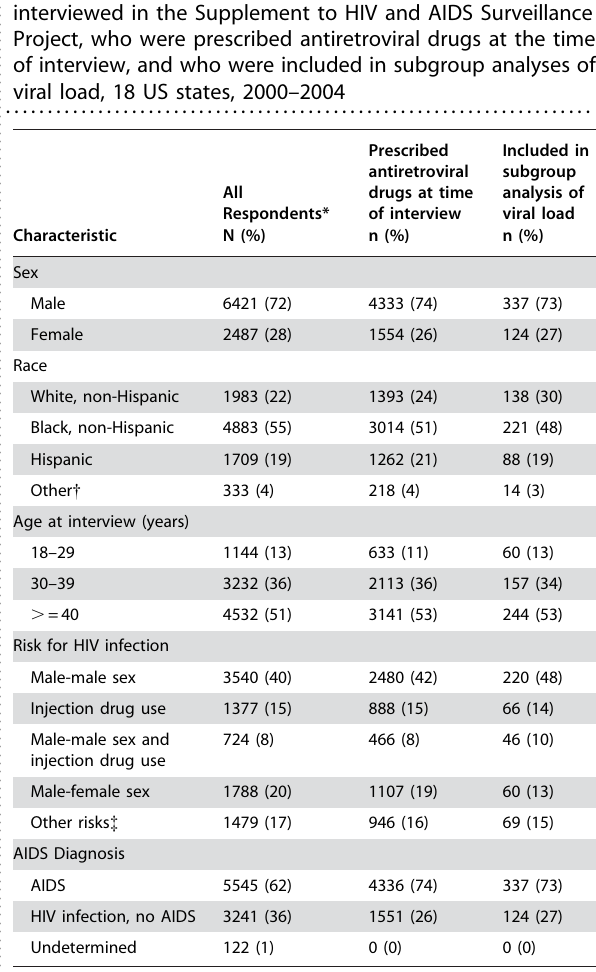
Table 1. Characteristics of persons with HIV infection interviewed in the Supplement to HIV and AIDS Surveillance Project, who were prescribed antiretroviral drugs at the time of interview, and who were included in subgroup analyses of